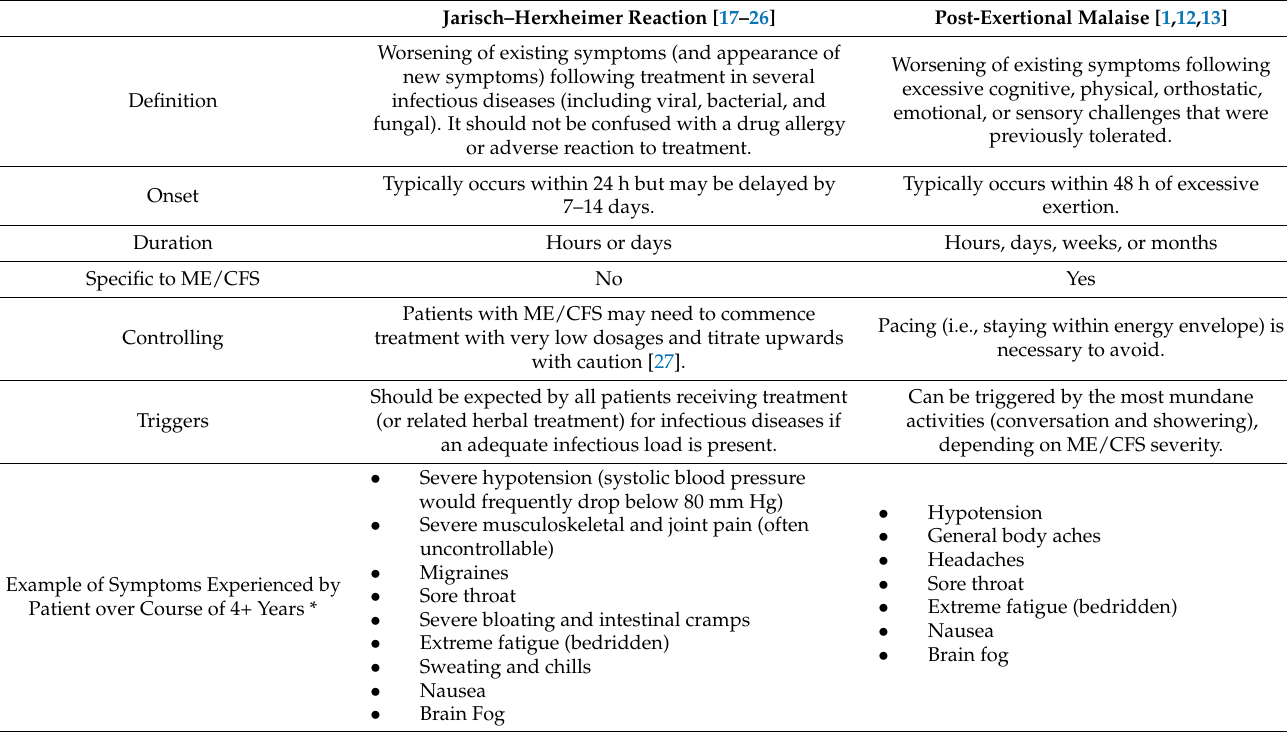
Table 1. Jarisch–Herxheimer Reaction vs. Post-Exertional Malaise.